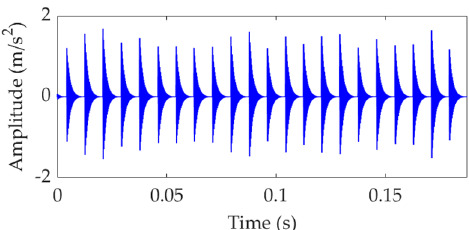
Figure 2. Vibration signal s ( t ) with fault-related impulsive features.